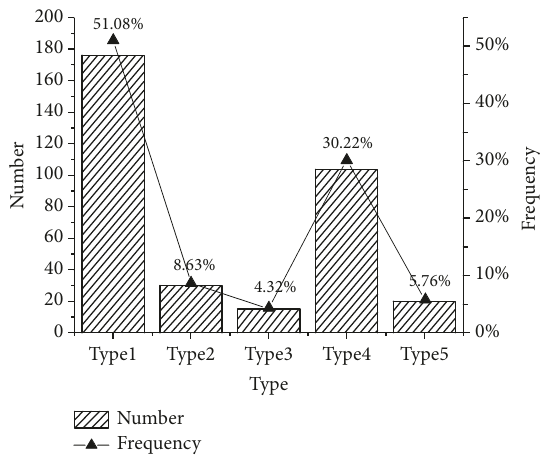
Figure 6: Profiles of each decision type: 1 (pass), 2 (stop), 3 (stop- pass), 4 (pass-stop), and 5